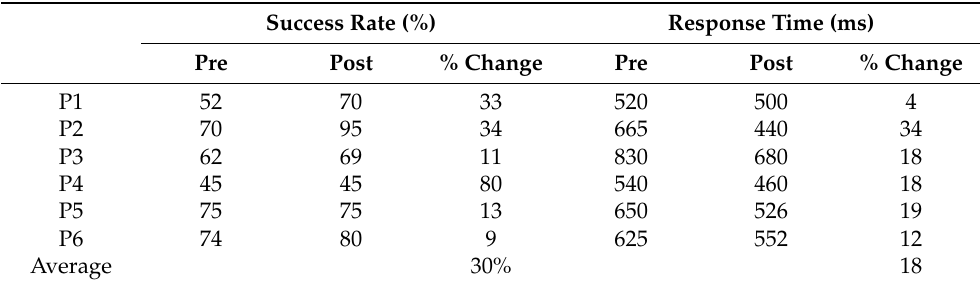
Table 5. Pre- and post-exercise test scores and percentage change in the fine rotation manipulation task for each child. Values are the average of leftward and rightward rotation game